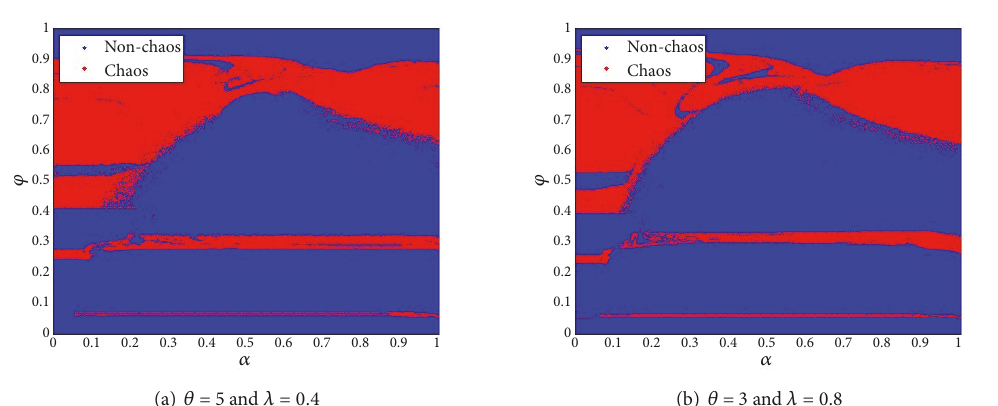
Figure 7: The system’s state for different 𝛼 and 𝜑 for ( 𝜃 = 5, 𝜆 = 0.4) and ( 𝜃 = 3, 𝜆 =